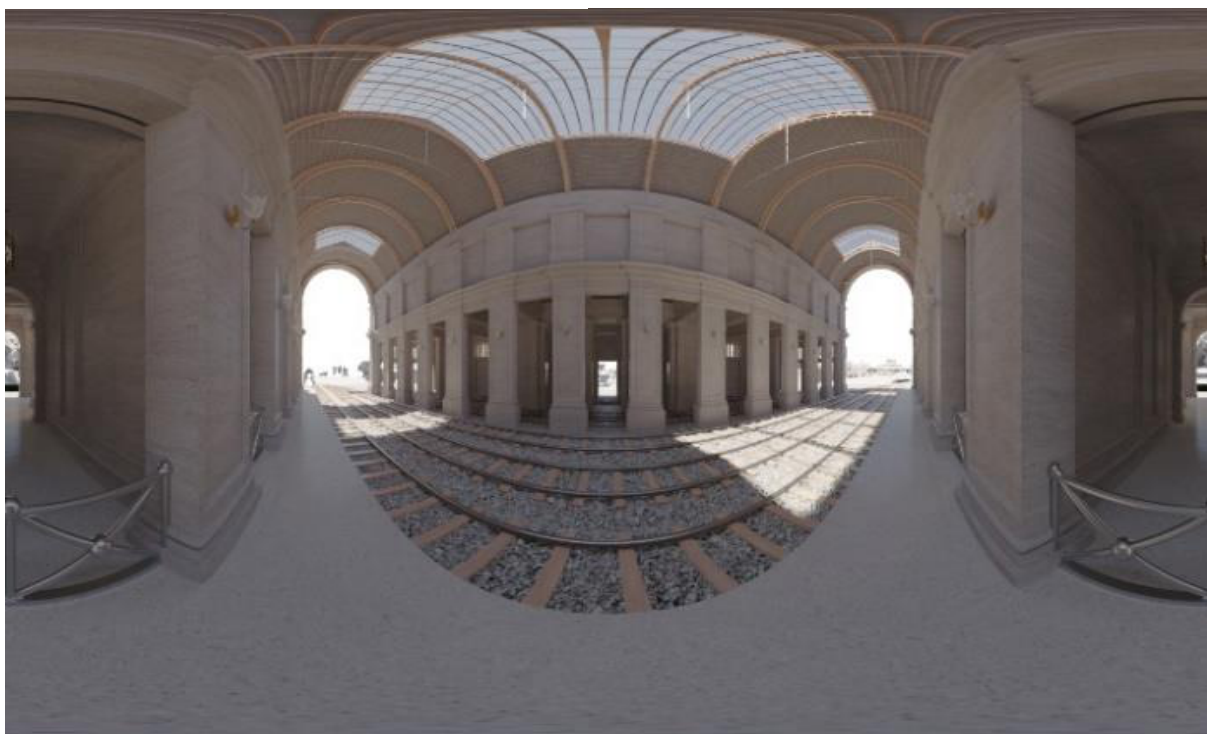
Figure 9. Spherical image of the arrival of rails in 360° angle